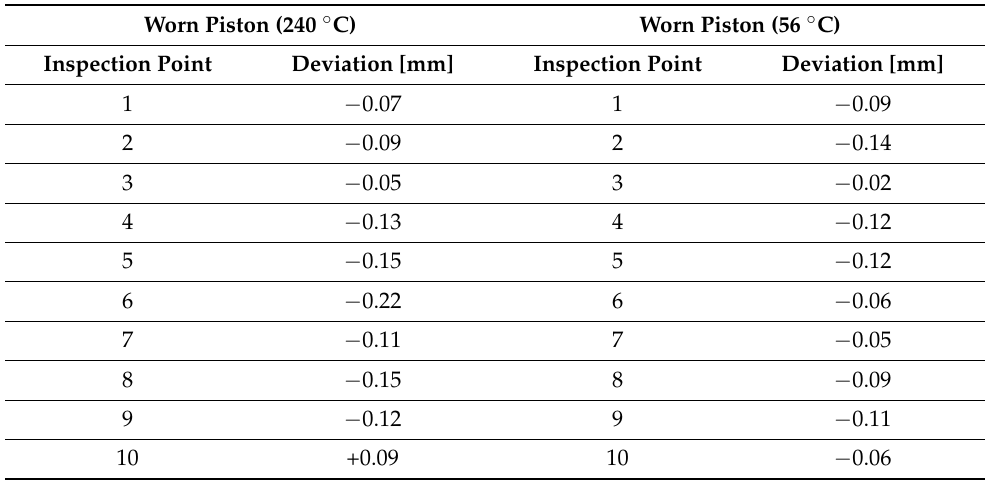
Table 3. Example results of the deformation of the worn piston during the cooling process (NaN— data not available (deviations not determined) as a result of reflexes and thermal radiation leading to static disadvantages for optical measurement